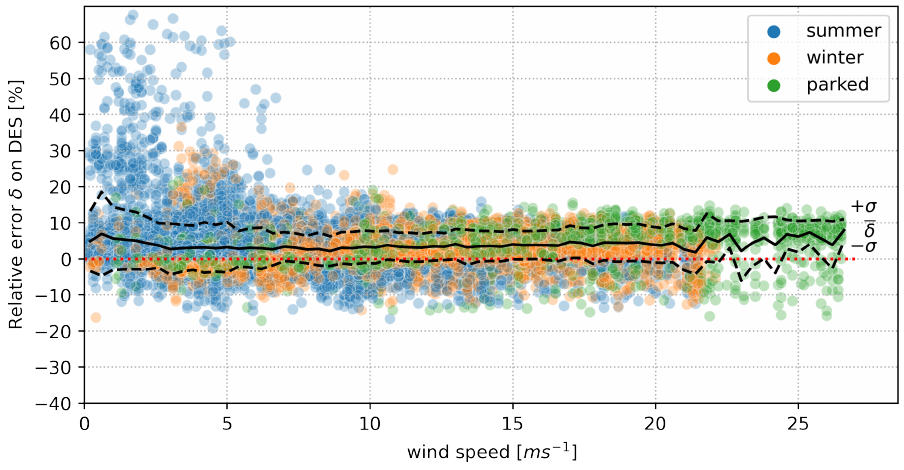
Figure 13. Relative error on DES of all sensors and validations sets combined over wind